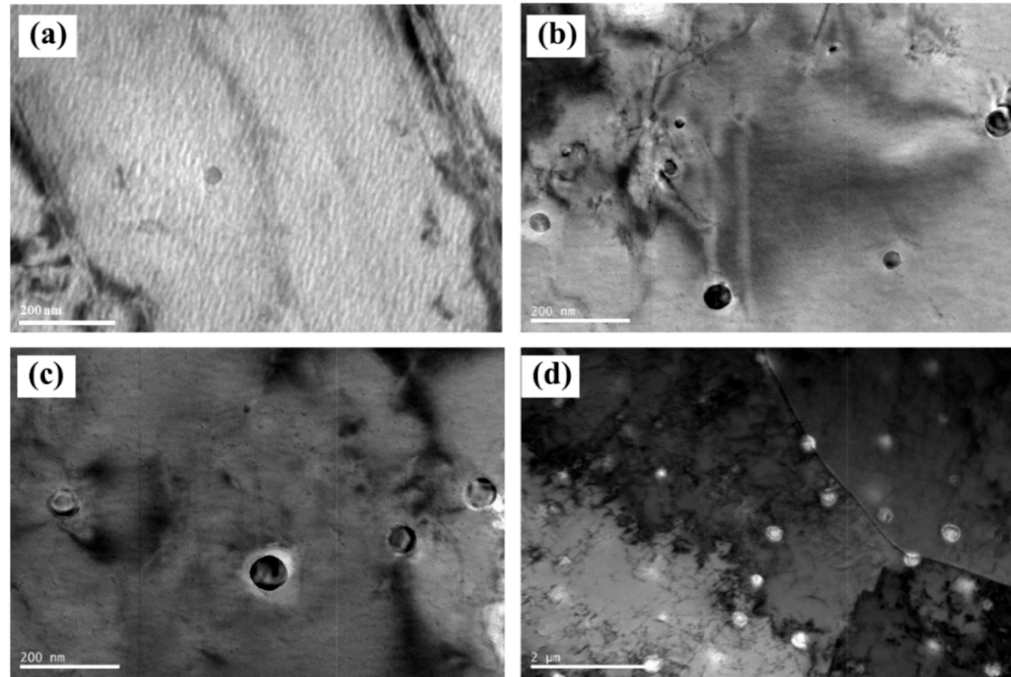
Figure 4. TEM micrograph showing the distribution of carbides aged at different holding times: ( a ) 1 h, ( b ) 2 h, ( c ) 5 h and ( d ) 10 h.